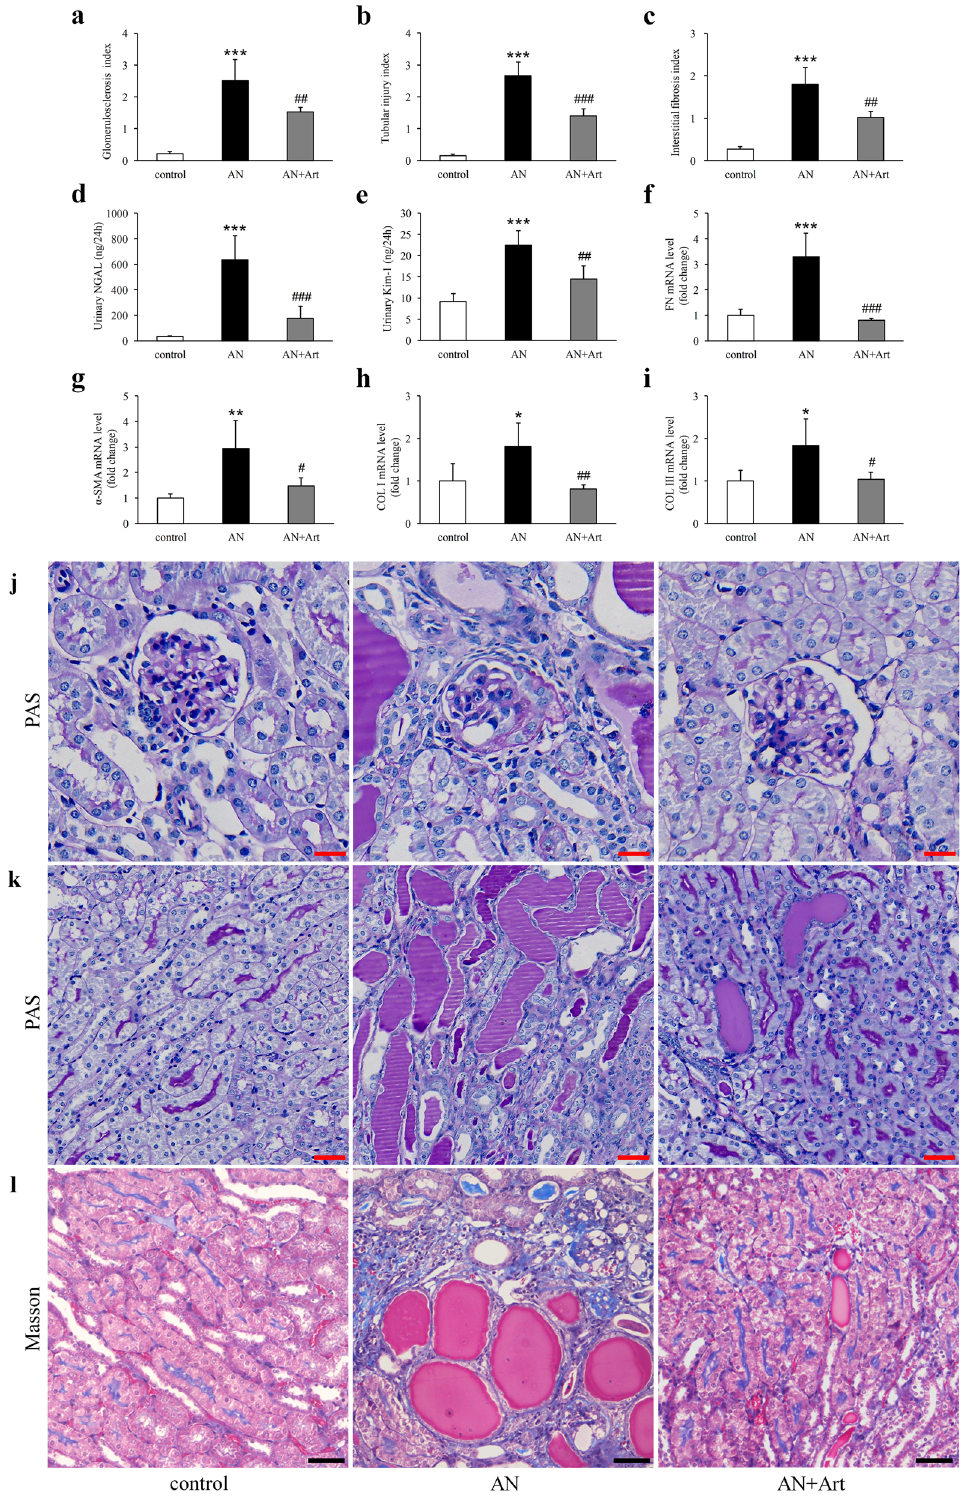
Figure 2. Artemether attenuated pathological changes and renal tubular injury. Evaluation of ( a ) glomerulosclerosis, ( b ) tubular injury, and ( c ) interstitial fibrosis in each group. Quantification of urinary ( d ) NGAL and ( e ) Kim-1 excretion in various groups. Determination of renal mRNA expression levels of ( f ) FN, ( g ) α-SMA, ( h ) COL I, and ( i ) COL III in different groups by qPCR and normalization against the housekeeping gene β-actin. ( j , k ) Representative images of PAS staining for glomeruli (scale bar, 20 μm) and tubules (scale bar, 50 μm). ( l ) Representative images of Masson trichrome staining for renal tubulointerstitium. Scale bar, 50 μm. n = 6 per group. * P < 0.05, ** P < 0.01 and *** P < 0.001 versus control; # P < 0.05, ## P < 0.01 and ### P < 0.001 versus